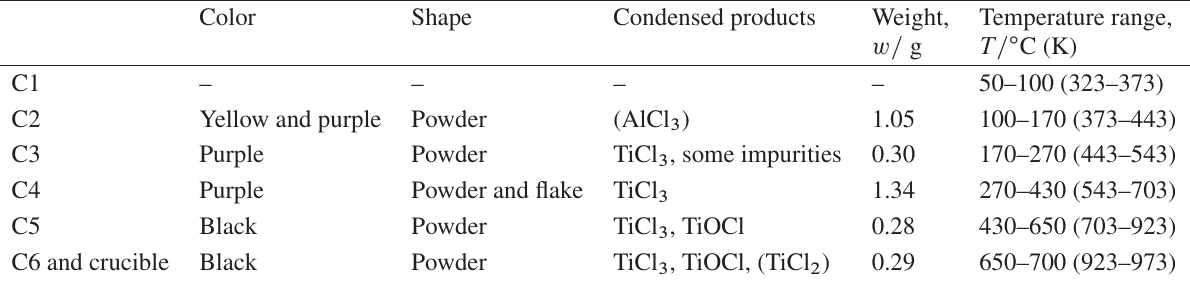
Table 1. The condensed products in each collector and the temerature range in which the products condensed. The com- pounds which is not identified by XRD are also listed in parentheses.